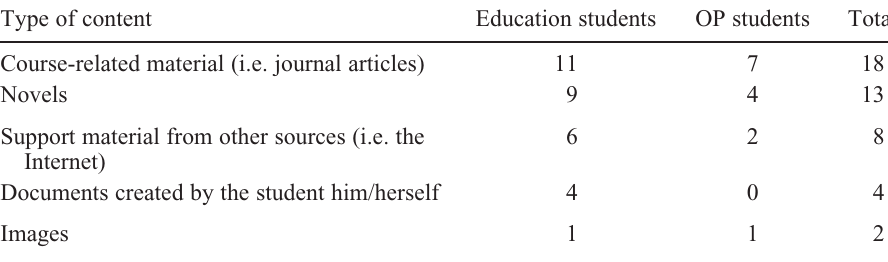
Table 8. Content added by learners to their e-book readers. Type of